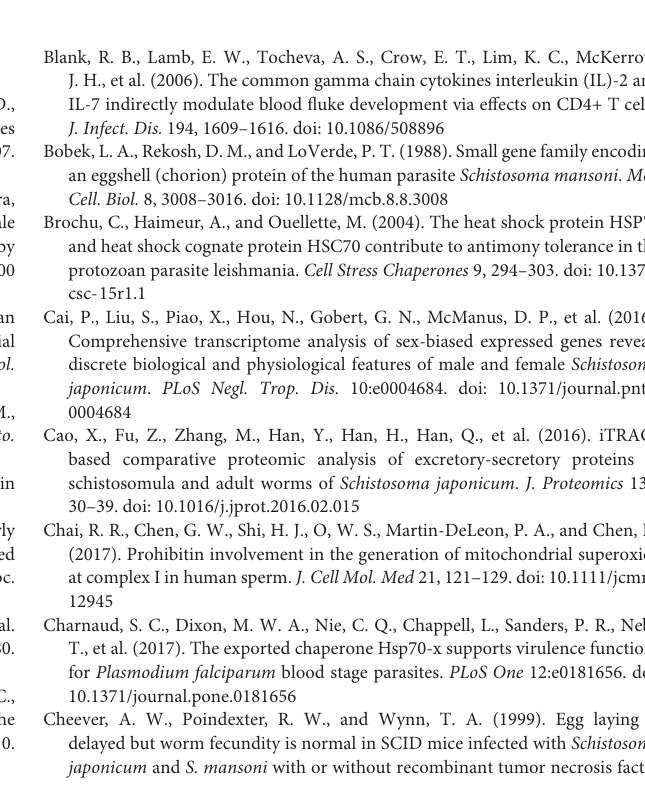
TABLE S11 | (a) dsRNA-mediated RNAi effects assessment (worm burden). (b) dsRNA-mediated RNAi effects assessment (pairing rate). (c)